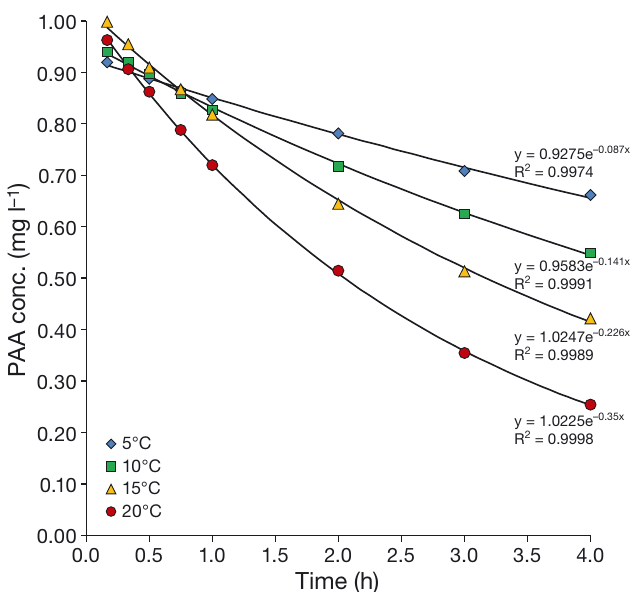
Fig. 1. Peracetic acid (PAA) decay in full-strength seawater at 4 different temperatures. Symbols reflect average PAA con- centration (n = 3) with the respective first-order exponential regression lines (Eq. 2)